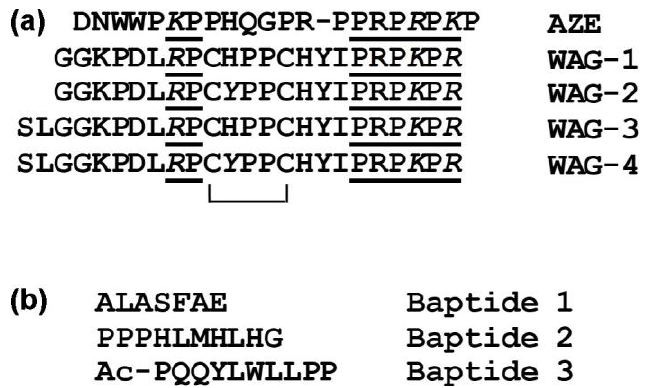
Figure 2. ( a ) Amino-acid sequences of azemiopsin and waglerins. Homologous fragments are underlined. AZE — azemiopsin (UniProt KB-B3EWH2) from A. feae ; WAG-1 (UniProt KB-P24335), WAG-2 (UniProt KB-P58930), WAG-3 (UniProt KB-P24335) and WAG-4 (UniProt KB-P58930) are waglerin-1, 2, 3 and 3, respectively, from T. wagleri . ( b ) Amino acid sequences of baptides from B. arietans . Waglerins are lethal peptides with an LD 50 of 0.22–0.58 mg/kg i.p. in adult